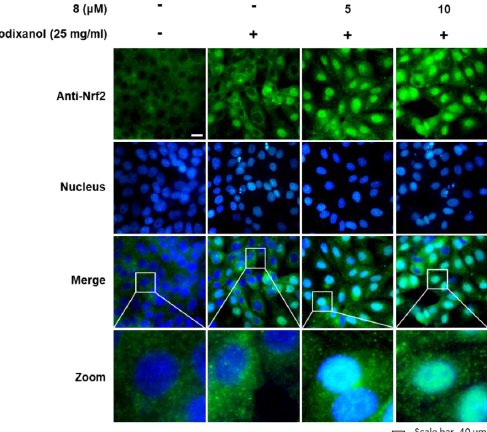
Figure 6. The effects of 3- epi- iso -seco -tanapartholide (compound 8 ) on the nuclear translocation of Nrf2 in LLC-PK1 cells exposed to iodixanol. LLC-PK1 cells were treated with 25 mg/mL iodixanol in the presence or absence of 8 , and immunofluorescence staining was performed using antibodies for Nrf2 that were visualized with a goat anti-rabbit IgG-heavy- and light-chain FITC-conjugated antibody (green fluorescence) and mounted with ProLong® Gold antifade reagent with DAPI-stained nuclei (DAPI). The white arrows indicate the presence of Nrf2. White scale bar, 40 µm. Staining with annexin V Alexa Fluor 488, an apoptosis indicator, and propidium iodide (PI), a necrosis indicator, was used to assess the effect of compound 8 on iodixanol-induced apoptosis in LLC-PK1 cells. As shown in Figure 7B, the percentage of cells stained with annexin V Alexa Fluor 488 (green fluorescence) undergoing apoptosis increased significantly by 54.9% ± 3.2% after treatment with 25 mg/mL iodixanol, whereas it was decreased by treatment with 2.5, 5, and 10 μM of compound 8 , prior to treatment with iodixanol, to 40.6% ± 1.5%, 28.8% ± 2.8%, and 13.7% ± 1.7%, respectively. However, the percentage of cells stained with PI (red fluorescence), indicating necrosis, did not show significant changes.